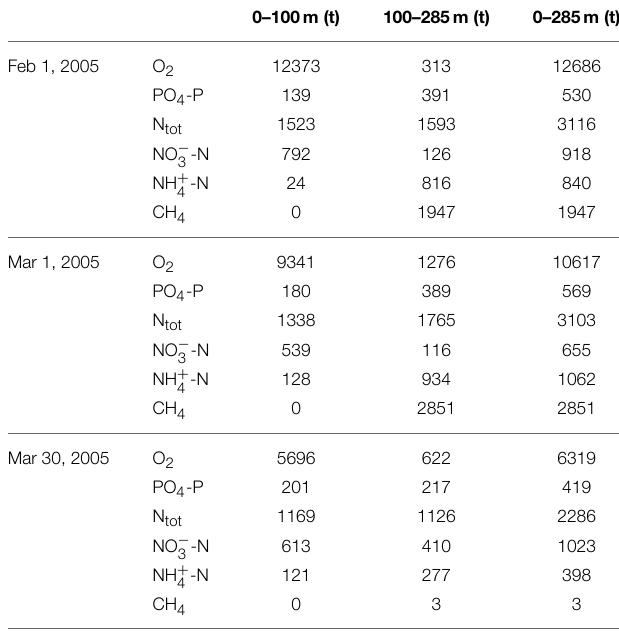
TABLE 1 | Compartmental and whole-basin changes of the O 2 , PO 3 − 4 -P, fixed N, and CH 4 inventories (in metric tons, t) in the northern basin of Lake Lugano, associated with the destabilization of the water column during winter